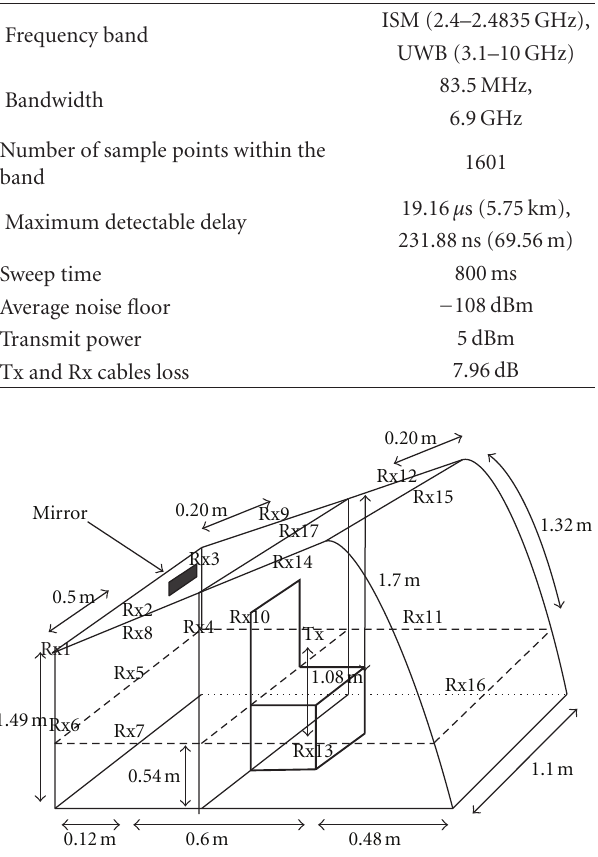
Figure 1: Arrangement of the antennas’ positions for measure- ments inside a working machine